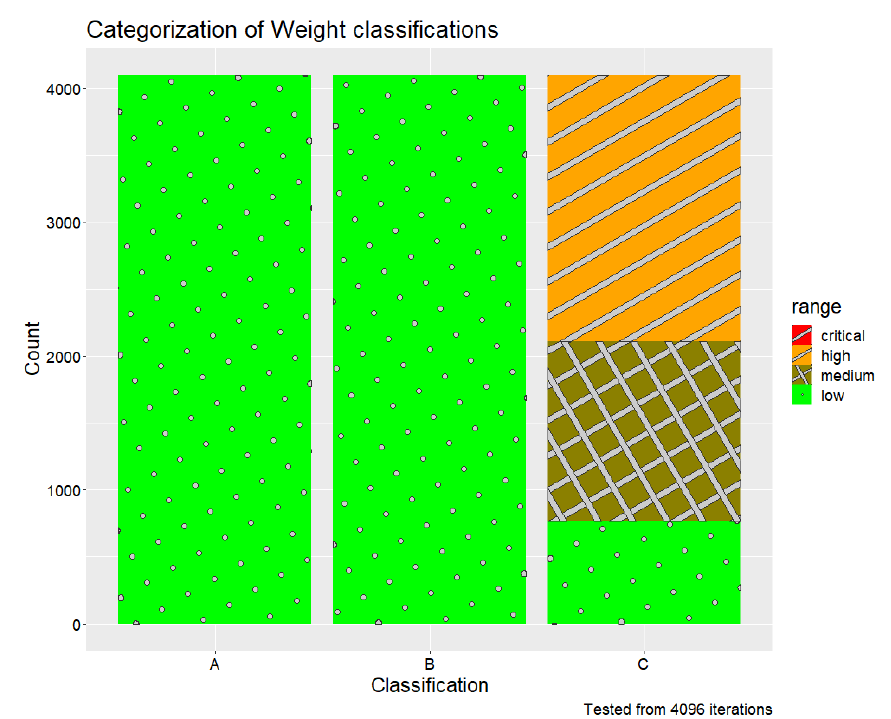
Figure 5. Tested Weight